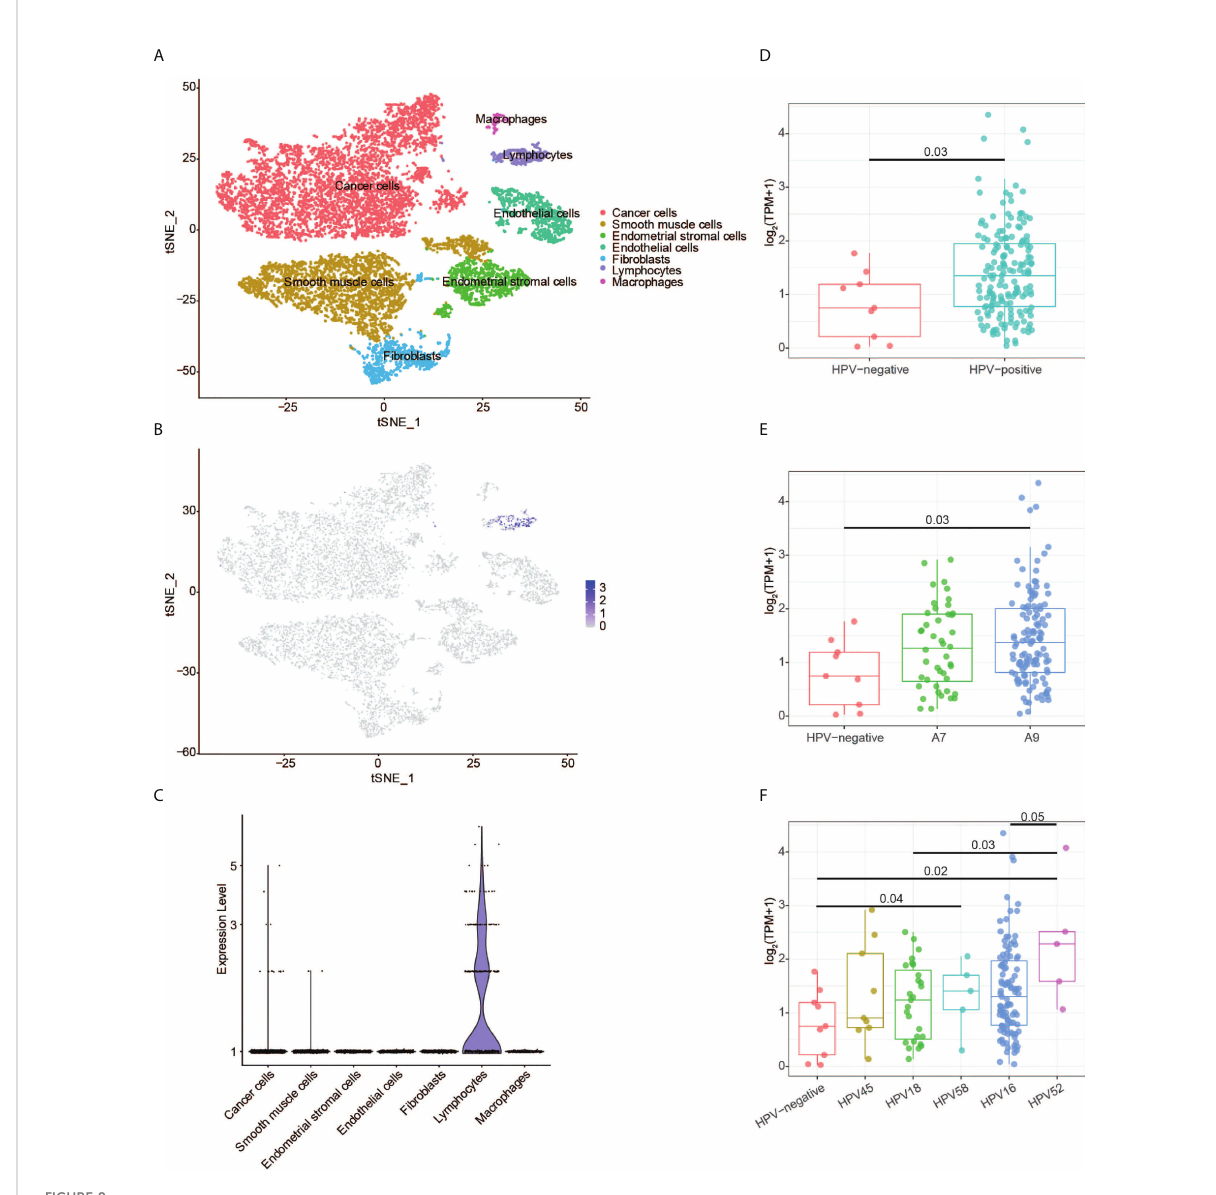
FIGURE 8 CD3G expression revealed by single-cell RNA sequencing and HPV genotype analyses. (A) The t-SNE plot of cells from the normal tissues and cervical cancer. (B) The t-SNE plot showing the CD3G expression. (C) The enrichment of CD3G in lymphocytes subgroup in cervical cancer. (D-F) The correlation of CD3G expression and HPV